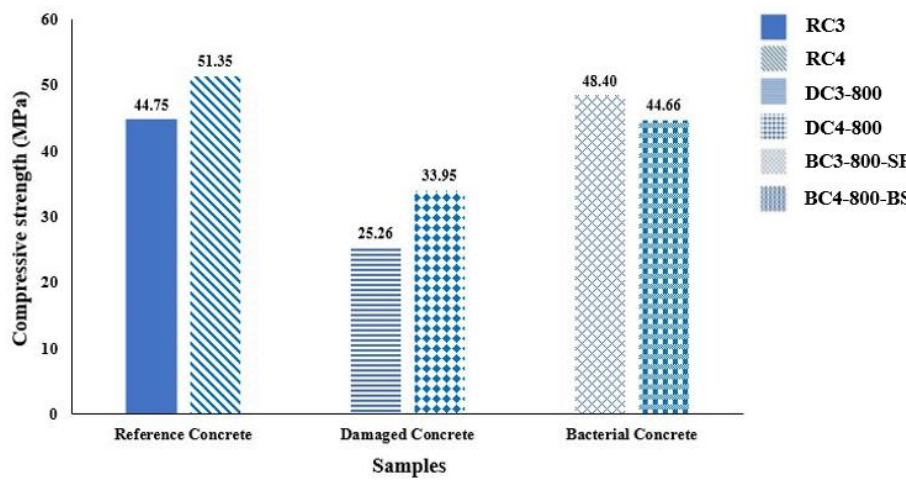
Figure 5. Comparing compressive strength results of the control specimens, damaged at 800 °C and repaired by type I and II bacteria. repaired by type I and II